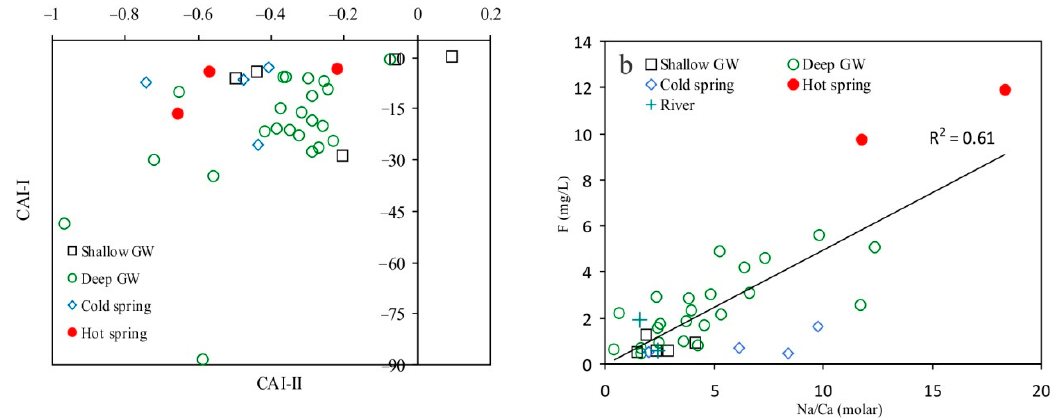
Figure 7. ( a ) plot of CAI-II vs. CAI-I of groundwater samples from the Bilattie River Basin [58] and Figure 7. ( a ) , plot of CAI ‐ II vs. CAI ‐ I of groundwater samples from the Bilattie River Basin [58] and ( b ) plot of F − vs. Na/Ca ( b ) plot of F − vs . Na/Ca ratio.